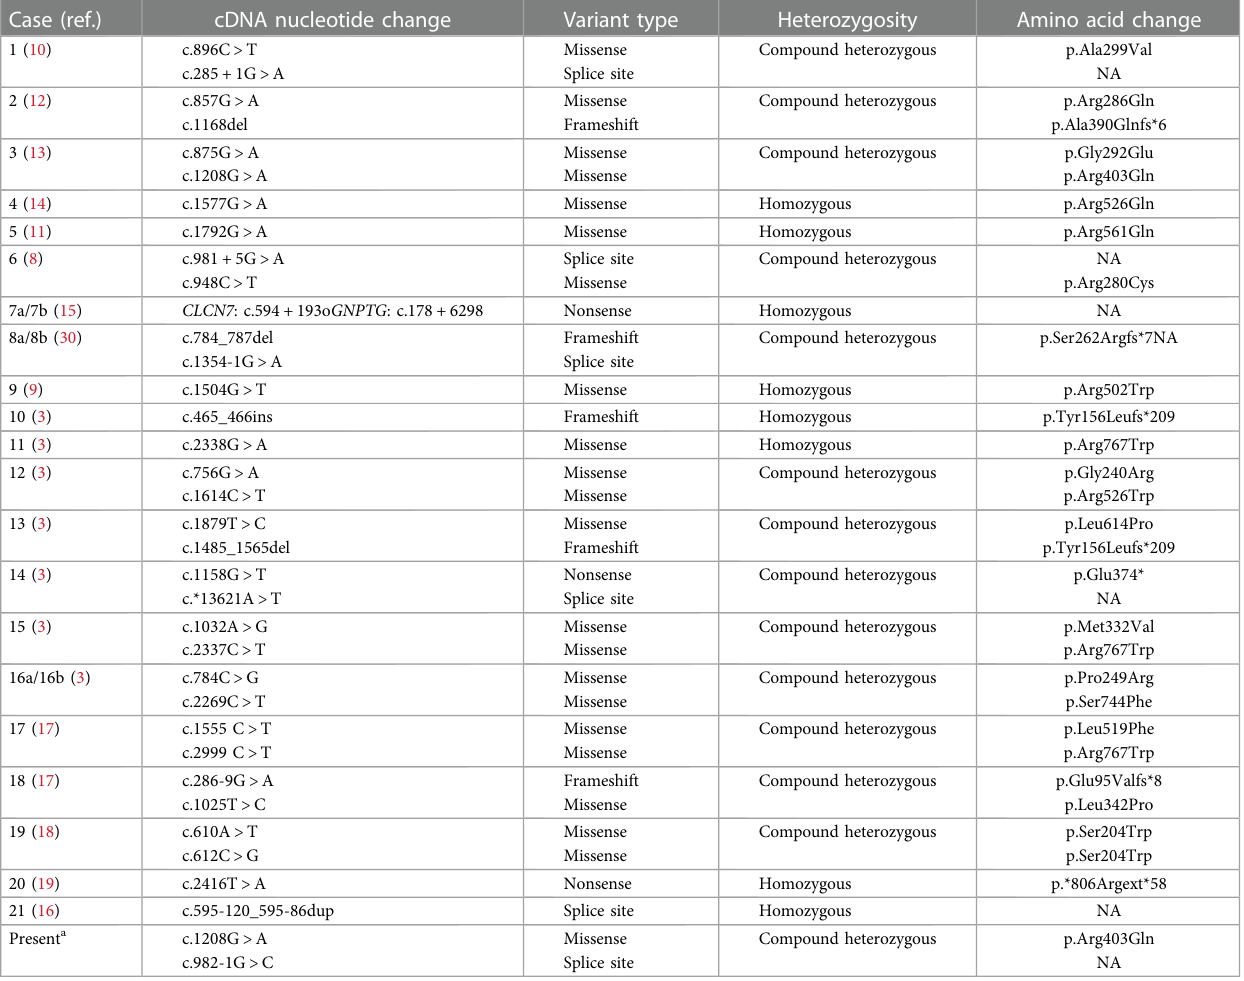
TABLE 3 The molecular variants in CLCN7 in our patient and others in the literature. Case